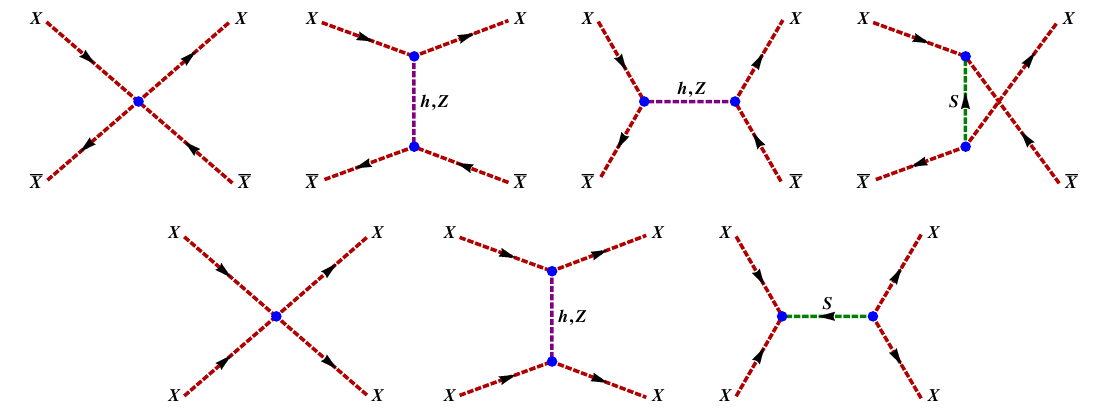
(cid:0) (cid:1) XX ! XX . For the process (cid:22) X (cid:22) X ! (cid:22) X (cid:22) X , the relevant